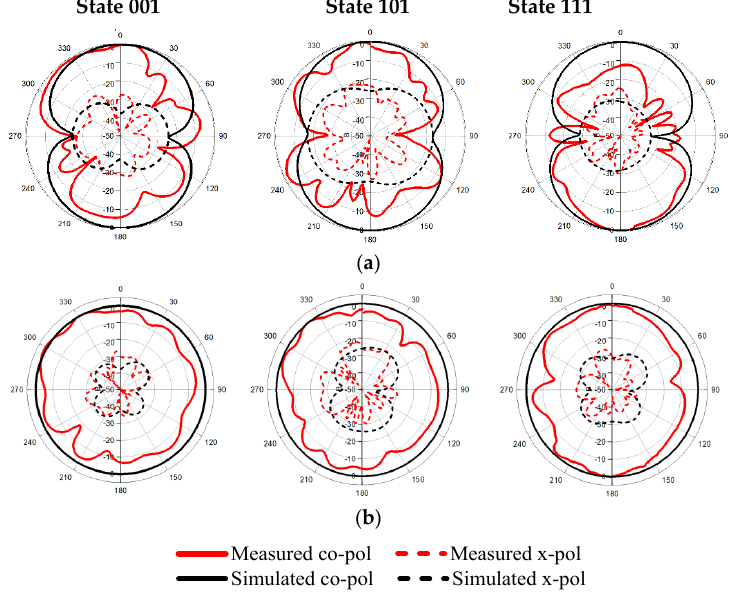
Figure 11. Simulated and measured radiation patterns at their corresponding resonant frequencies of states 001 (1.28 GHz and 1.23 GHz), 101 (1.60 GHz and 1.52 GHz), and 111 (1.88 GHz and 1.79 GHz): ( a ) E-plane; ( b ) H-plane.